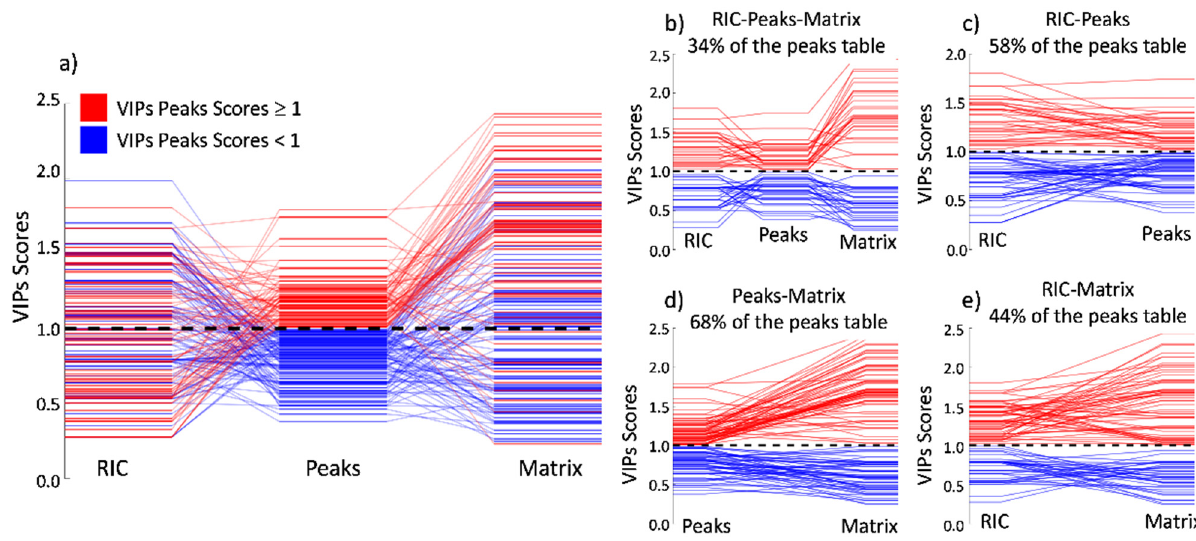
Figure 6. Permutation of the VIP score positions compared to the peaks model. ( a ) Comparison among the three approaches; ( b – e ) shows only the VIPs scores ratio that maintains its importance in the peer comparison. The higher matching occurs between the peak table and the full matrix, where 58% of the peaks keep their relative importance.